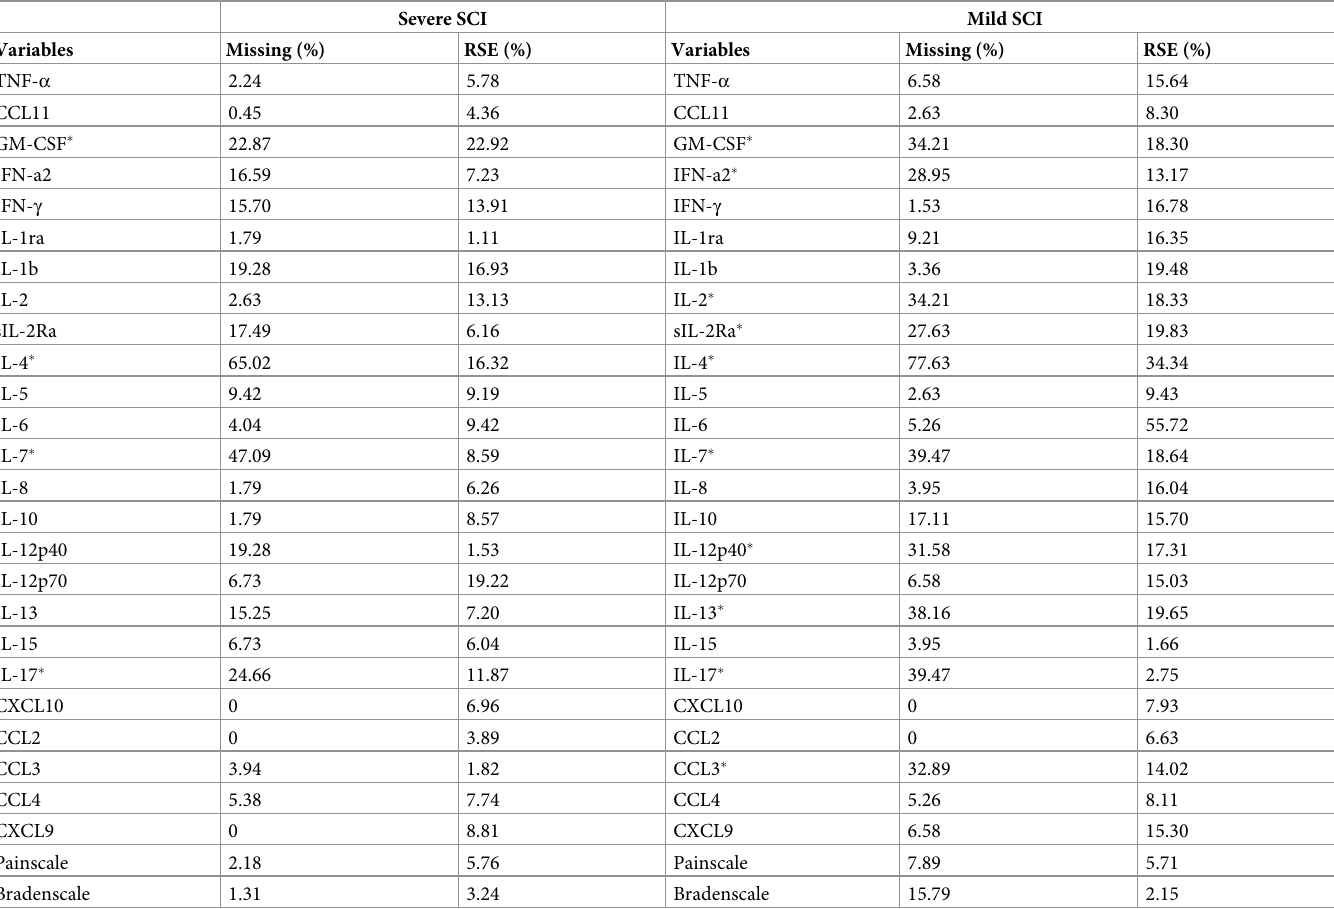
Table 2. Rate of missing for each inflammatory mediators and outcome